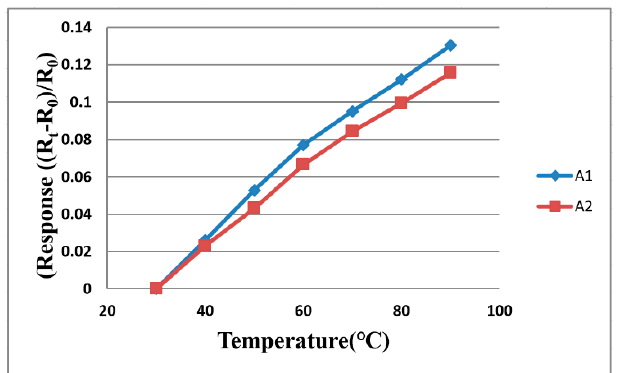
Figure 4. The correction curve of two micro temperature sensors.